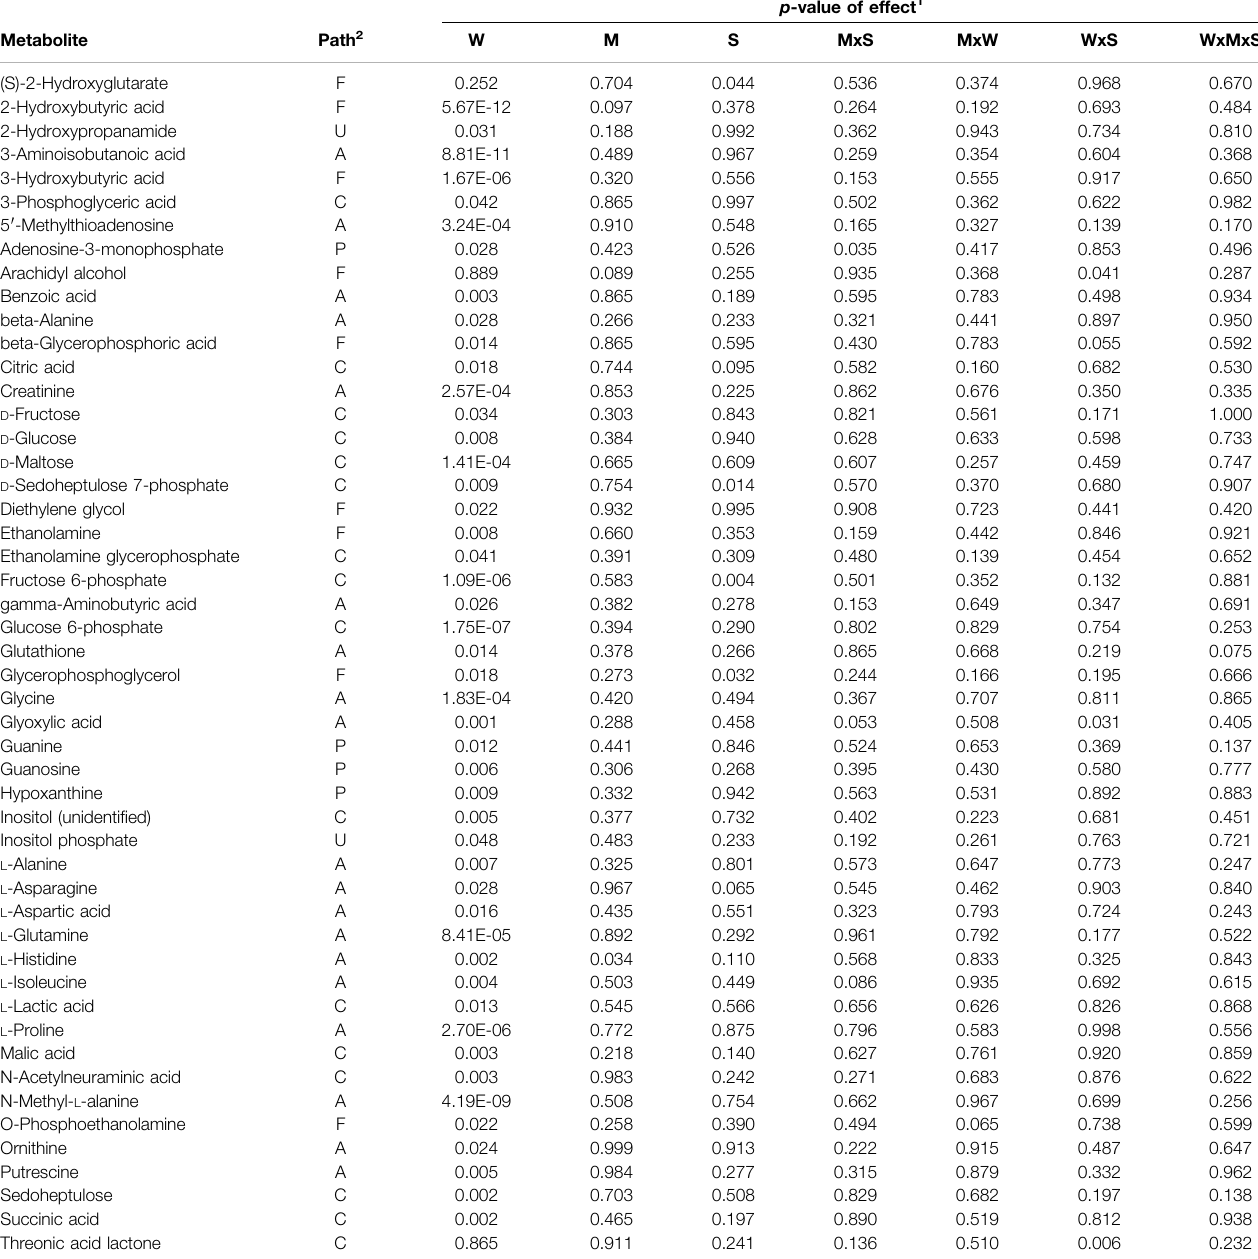
TABLE 1 | Metabolites presenting at least one effect, weaning alone or interacting with maternal immune activation or sex, at p -value < 0.05.